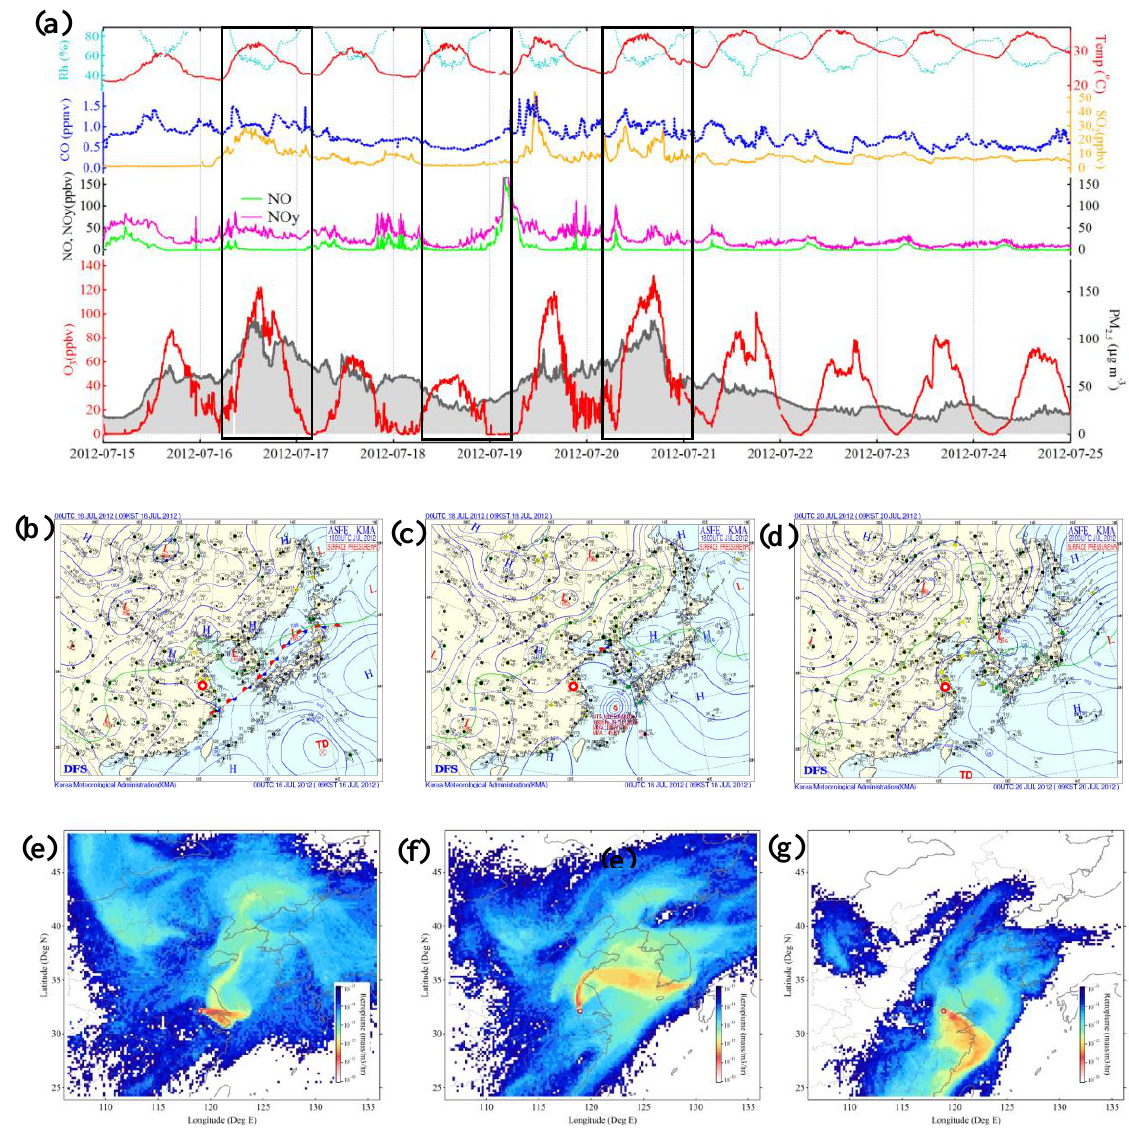
Figure 10 . ( a ) Same as Fig. 9( a ) but for Case IV, i.e. 15-25 July 2012. ( b-d ) and ( e-g ) show 2 Fig. 10. (a) Same as Fig. 9a but for Case IV, i.e., 15–25 July 2012; (b–d) and (e–g) show weather charts and averaged retroplumes for the three periods marked in (a) weather charts and averaged retroplumes for the three periods marked in Fig. 10( a ). 3